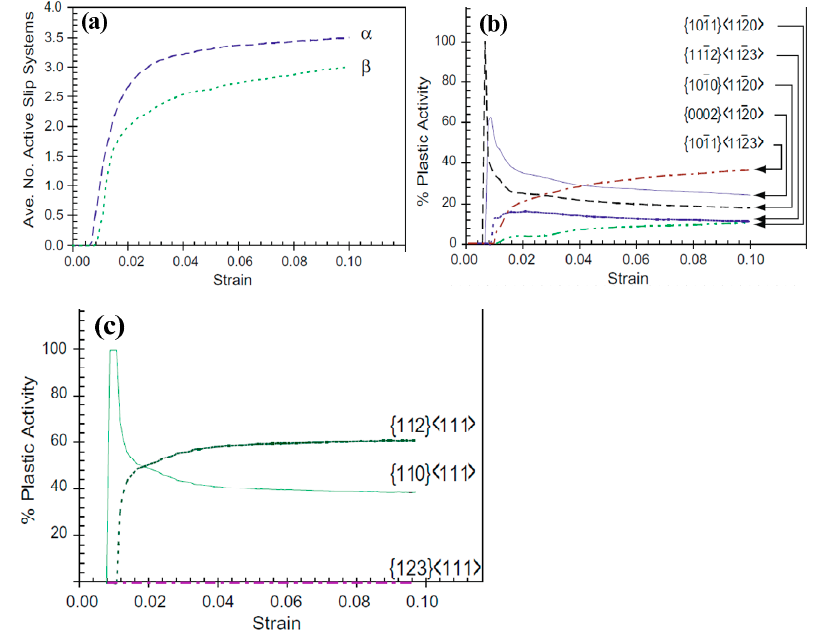
Figure 10. Average number of active slip systems per phase ( a ), relative distribution of active slip systems in the α ( b ) and β ( c ) phases, as predicted by the self-consistent model for the bar [83]. Reprinted with permission from Ref. [83]. Copyright 2008, Acta. Mater.